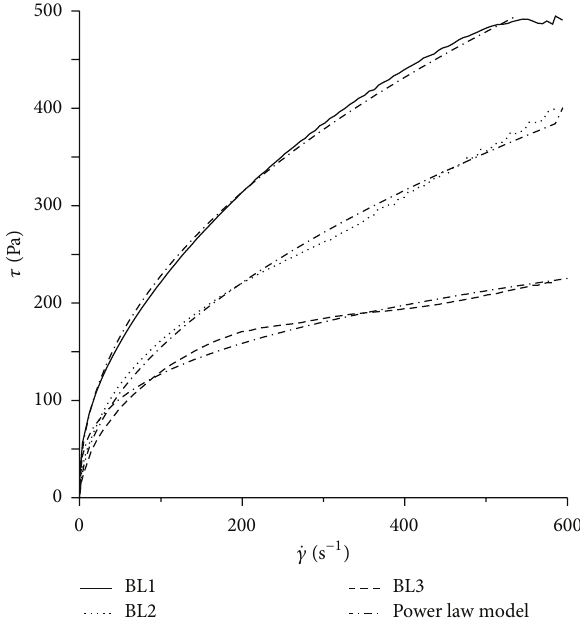
Figure 2: Approximation of the flow curves (upward direction) of BL1, BL2, and BL3 in the range of shear rates 10 −2 –600 s −1 by the power law